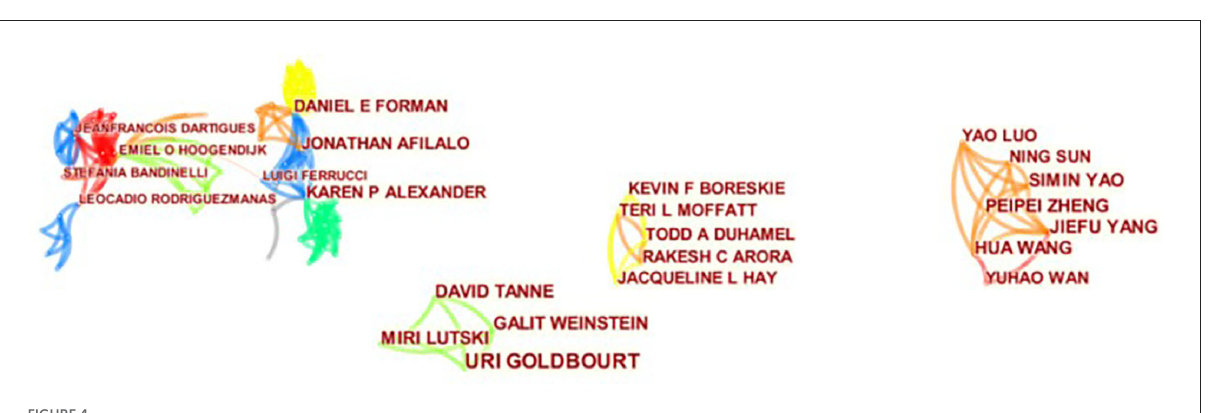
FIGURE4 Map of authors related to CVD with frailty from 2000 to